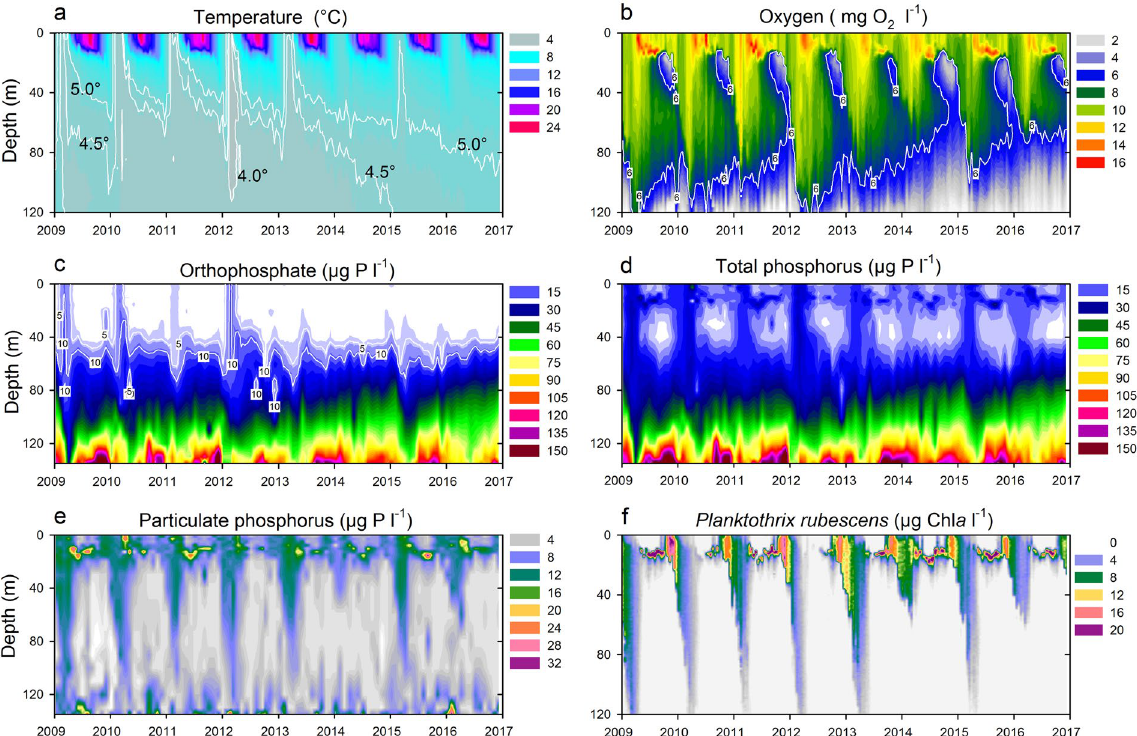
Figure 1. Recent trends (2009 to 2016) in warming, concentrations of oxygen and phosphorus, and cyanobacterial biomass in Lake Zurich (Switzerland). ( a ) Water temperature and two white isolines showing 4.5 °C and 5.0 °C, respectively. ( b ) Dissolved oxygen concentration and the 6 mg O 2 l − 1 isoline which is a proxy for the depth of maximal water turnover during spring. Note the metalimnetic oxygen minima developing each autumn expanding between 15–40 m water depths. Concentrations of dissolved orthophosphate ( c ), total phosphorus ( d ) and particulate (i.e., mostly organismic bound) phosphorus ( e ). ( f ) Total biomass (chlorophyll a concentration) of the most dominant primary producer in Lake Zurich, the cyanobacterium Planktothrix rubescens . Data based on biweekly profiles ( n = 192) of parameters measured in 1 m depth intervals (0 to 120 m depth) in a,b,f . Data based on monthly profiles ( n = 96) of 17 sampling depths ( n = 1,632) in c , d , e